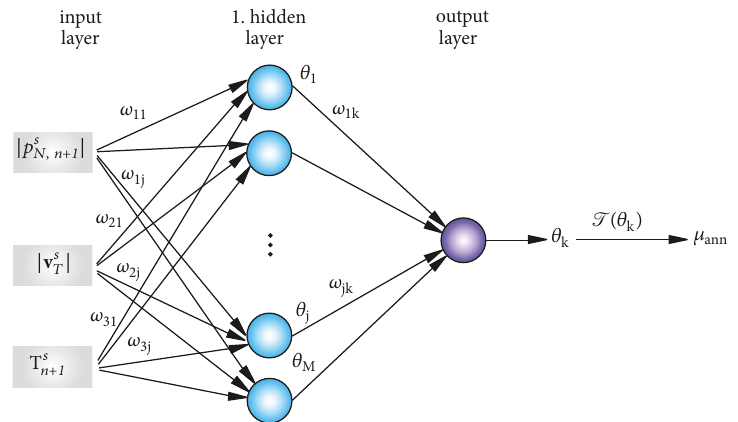
Figure 7: Architecture of an ANN applied for the computation of the friction coefficient 𝜇 𝑎𝑛𝑛